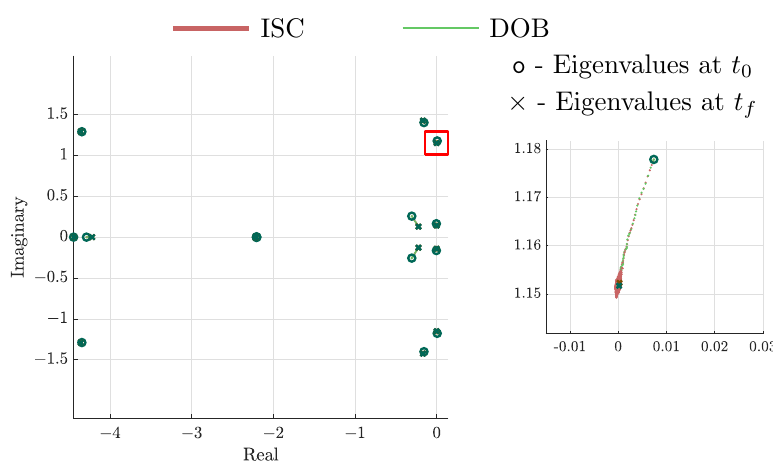
Figure 10. ( Top ): Evolution of θ 1 ( t ) ; ( Bottom ): Control effort required.